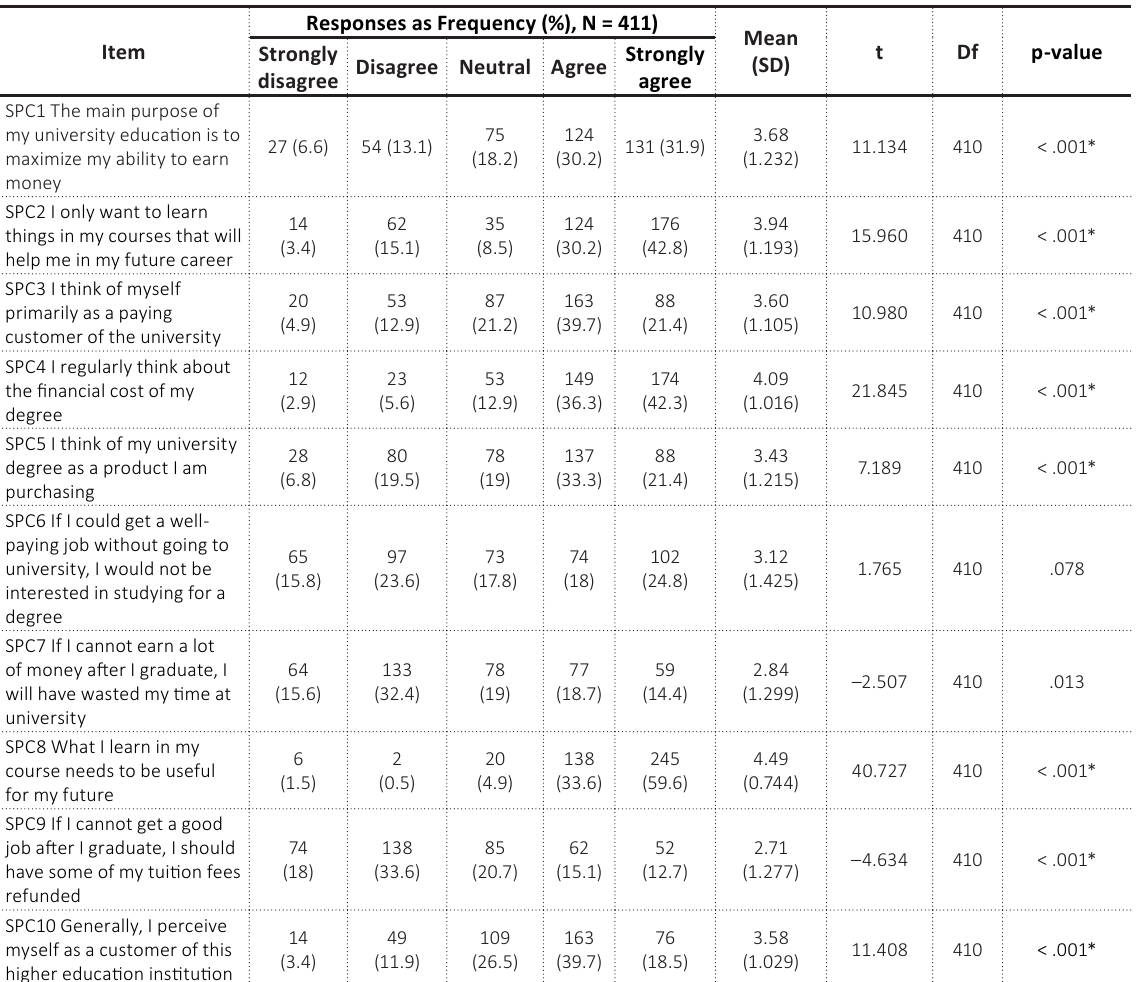
Table 4. Students’ perception of themselves as customers of